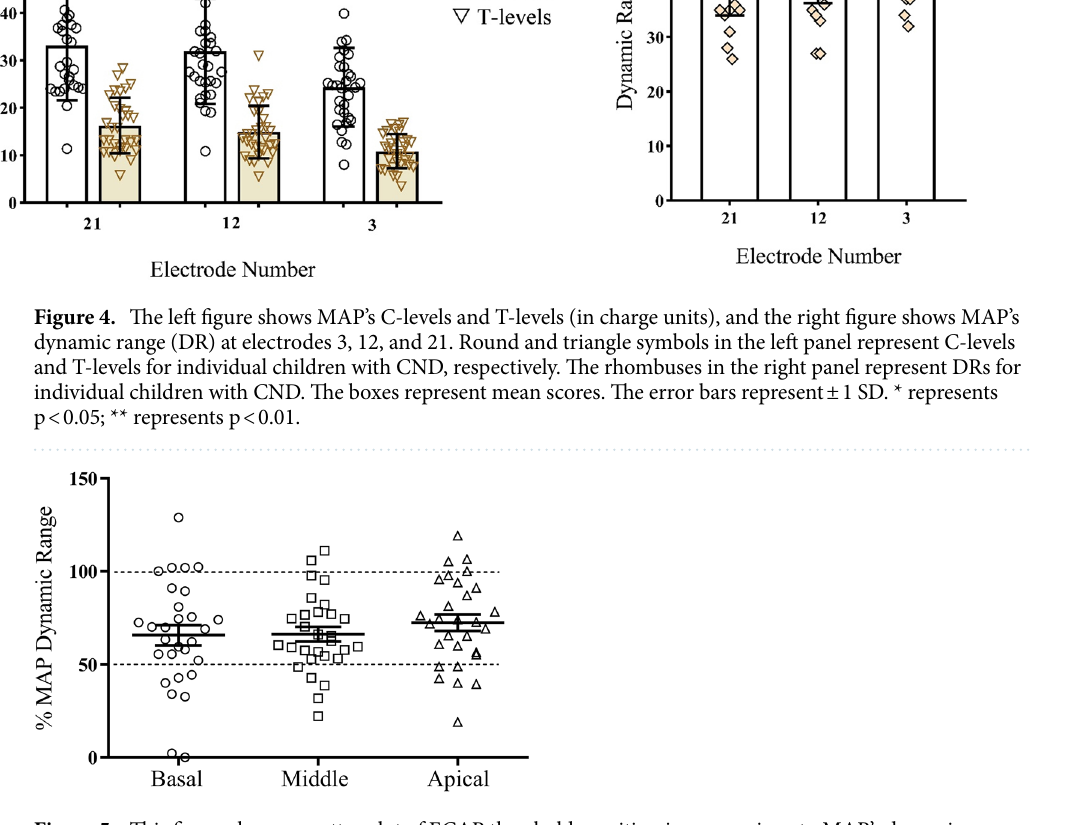
Figure 5. This figure shows a scatter plot of ECAP thresholds position in comparison to MAP’s dynamic range at the “Basal”, “Middle” and “Apical” electrode locations. The lower dotted line represents ECAP threshold fall at the middle of the MAP’s dynamic range, and the upper dotted line represents ECAP threshold is equal to the MAP’s comfortable level. The solid lines represent mean and standard error bar of the percentage of ECAP threshold to MAP’s dynamic